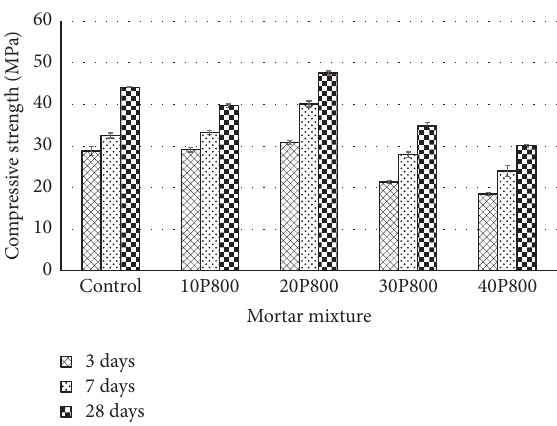
Figure 2: Mortar cured for 3, 7, and 28